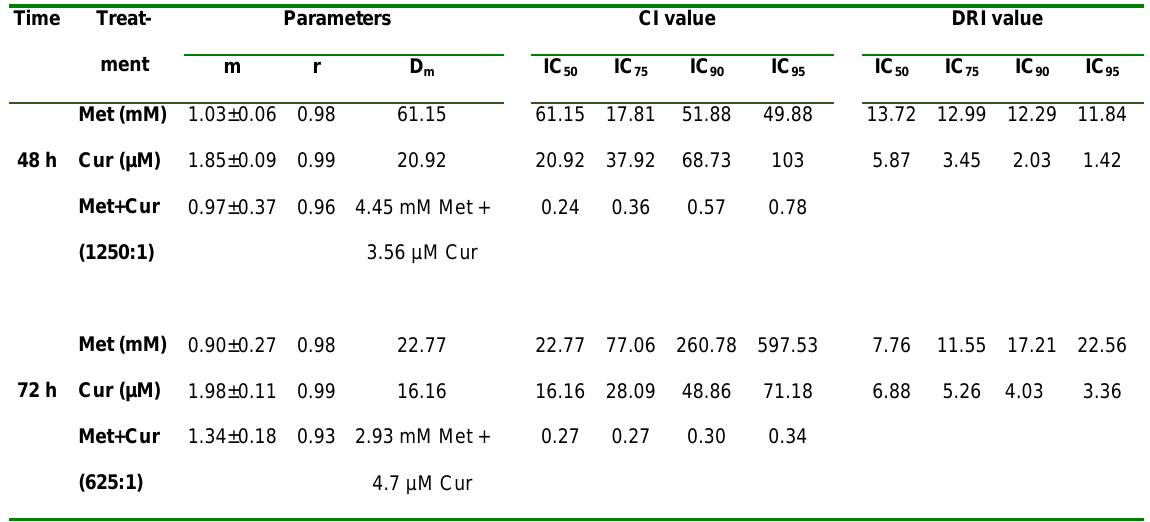
Table 1: Metformin (Met) and curcumin (Cur) combination synergistically inhibits cell viability in AGS